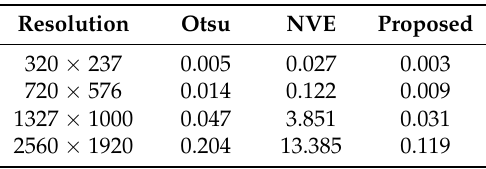
Table 1. Processing time comparison (Unit: